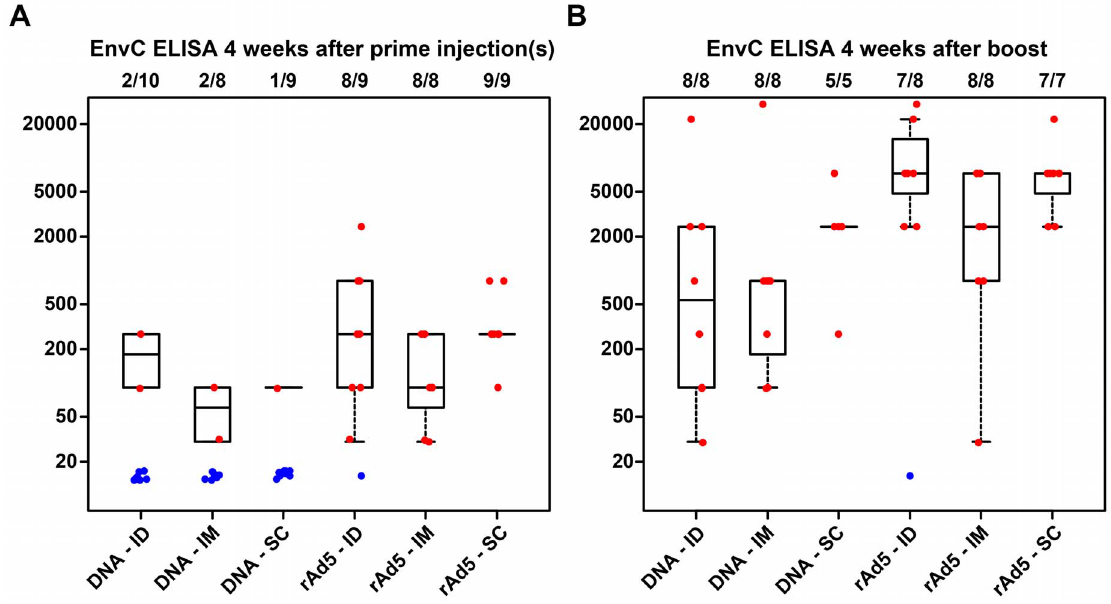
Figure 4. ELISA responses among the different groups after priming by route and vaccine indicated on X-axis (A) and boosting with rAd5 IM (B). The numbers above each boxplot represent the fraction of participants in each group with available data at that time point who were judged to be responders using predefined criteria. The responders are represented on the plot with red dots, and are used to construct the boxplots; blue points represent non-responders and are not included in the boxplots.